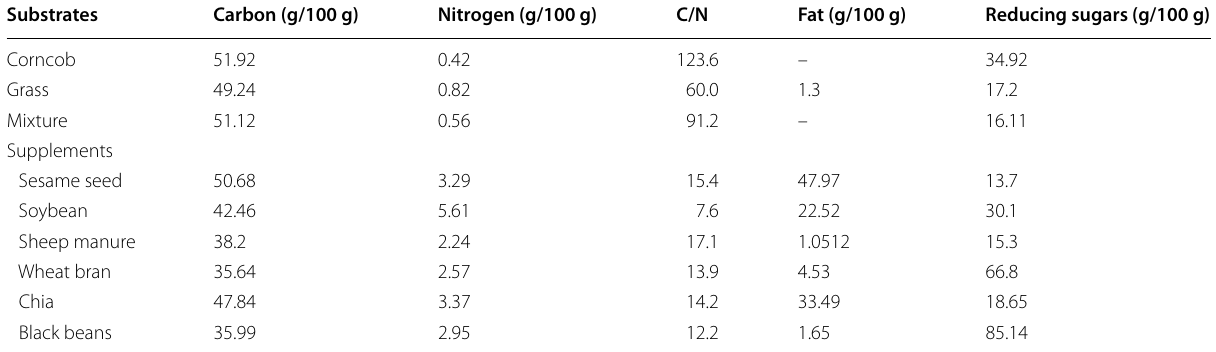
Table 6 Chemical composition of substrates and supplements used in this investigation Substrates